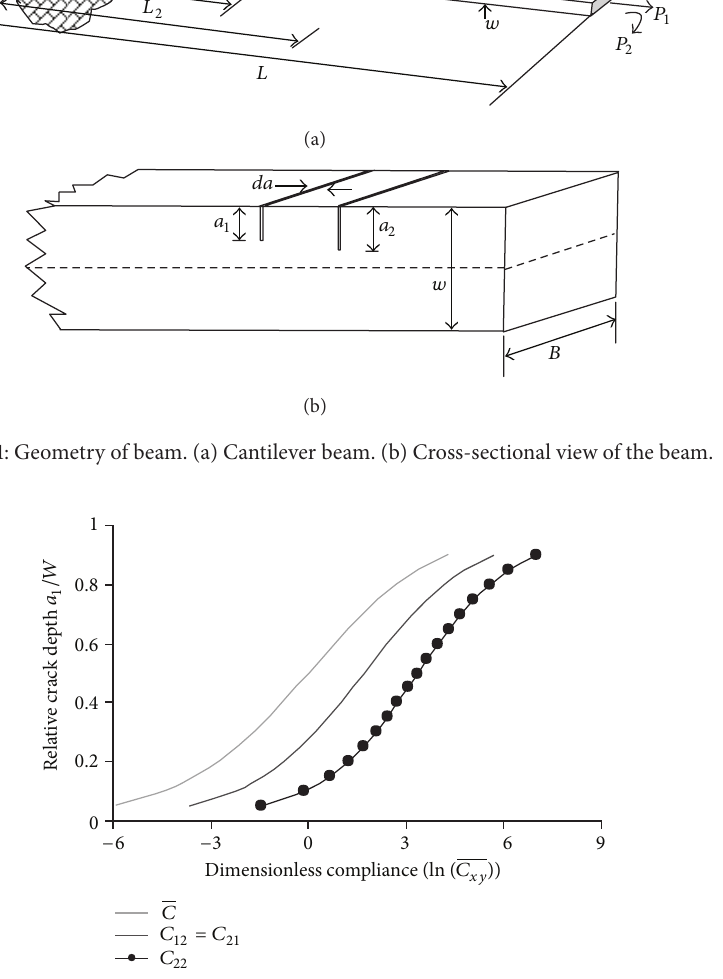
Figure 2: Relative crack depth (𝑎 1 /𝑊) versus dimensionless compliance (ln (𝐶 𝑥𝑦 ))